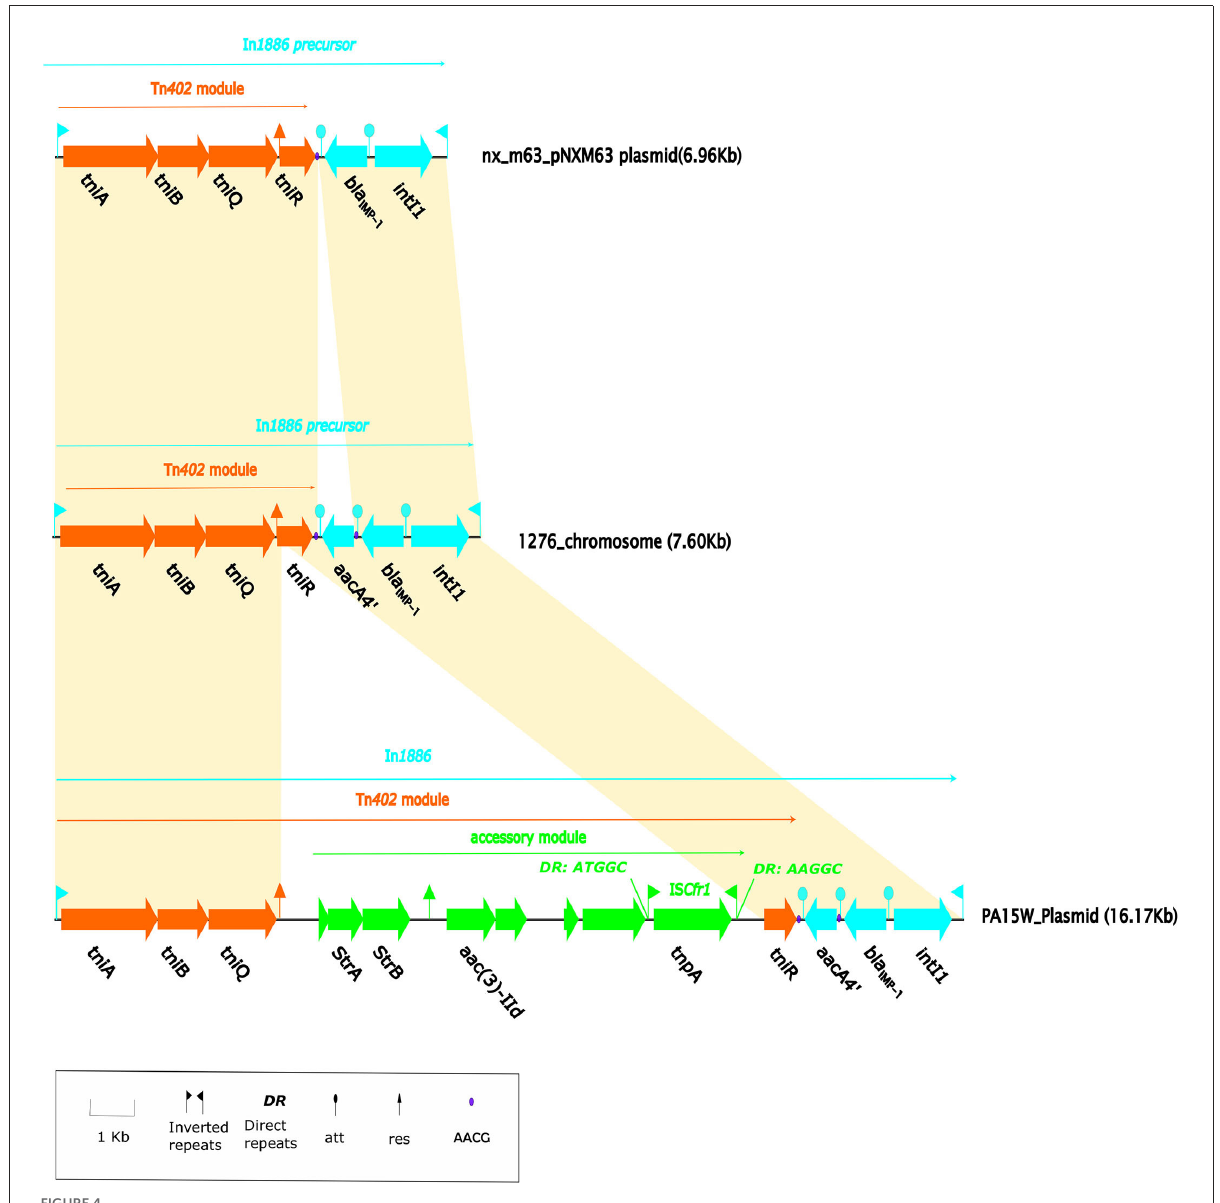
FIGURE4 Linear alignment map of In 1886. The Tn 402 transposition module is orange-red, the 3’-CS of the integron is blue, and the exogenous insertion element is green. The solid purple dot is the AACG sequence that is recognized by the gene cassette att and forms two copies in In1886 due to the insertion of the aacA4’ gene cassette. The shaded region represents a homologous region ( > 90% nucleotide identity). The pNXM63 (MW150990) from Morganella morganii nx_m63 contains an intI1 - bla IMP − 1 - tniABQR structure. When this integron was compared with In 1886 , except for the gene cassette aacA4’ , all of the bases were completely identical, and there was no missing base. At the same time, the downstream region of the gene cassette bla IMP − 1 in this integron contained the AACG site, which was present on both sides of the gene cassette aacA4’ in In 1886 . In addition, In 1886 was also present in the plasmid (GenBank accession no.: MN961673) in P. aeruginosa PA15W. However, a 7.45-kb exogenous insertion structure was inserted in the res_site_r1 recombination site of the Tn 402 mobile module in the Tn 402 of PA15W-In 1886 , causing res_site_r1 to be truncated (Supplementary Table 2). This exogenous insertion structure contained eight open reading frames (ORFs), including a complete IS Cfr1 (IS1182 family), aminoglycoside resistance genes strA and strB , and aac(3)-IId